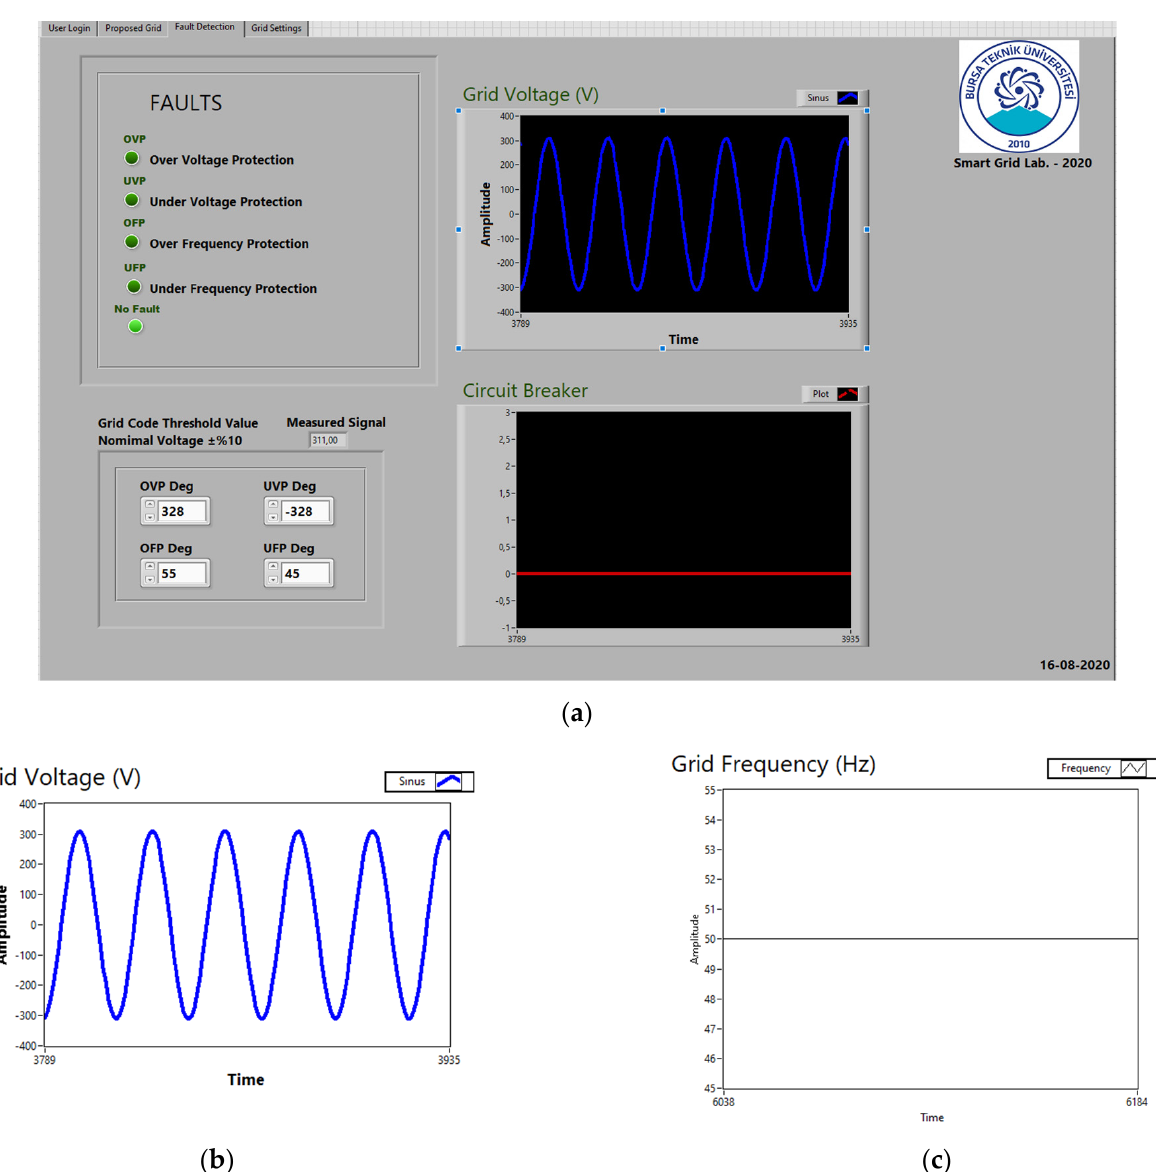
Figure 4. ( a ) Developed DGPS software; ( b ) monitoring grid voltage; ( c ) grid frequency.